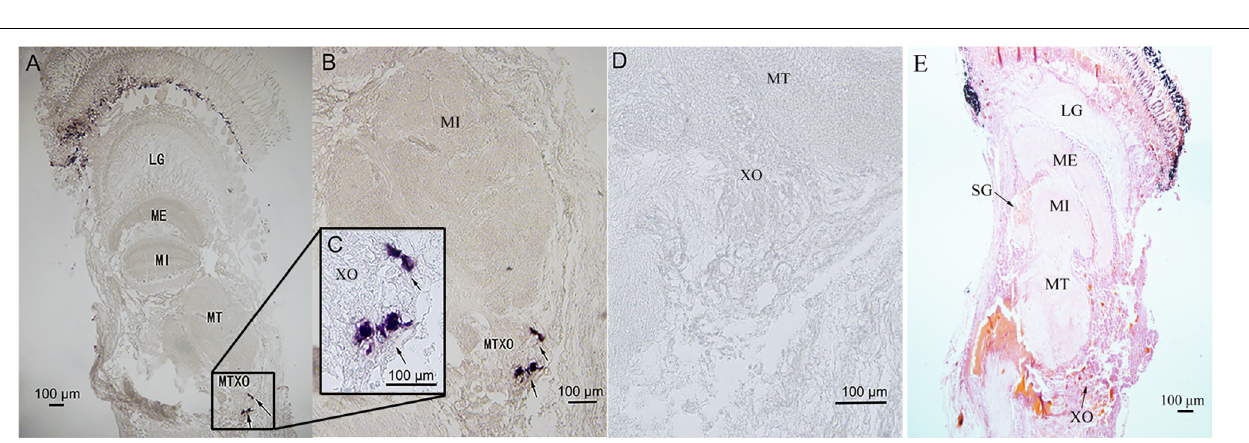
FIGURE 5 | Localization of Sp-CFSH- expressing cells in the eyestalk ganglia of male S. paramamosain . (A–C) Localization of Sp-CFSH mRNA by the antisense probe. Arrows indicate the positive signals of Sp-CFSH . (D) Negative control result with the sense probe. (E) Hematoxylin and eosin staining. LG, lamina ganglionaris; ME, medulla externa; MI, medulla interna; MT, medulla